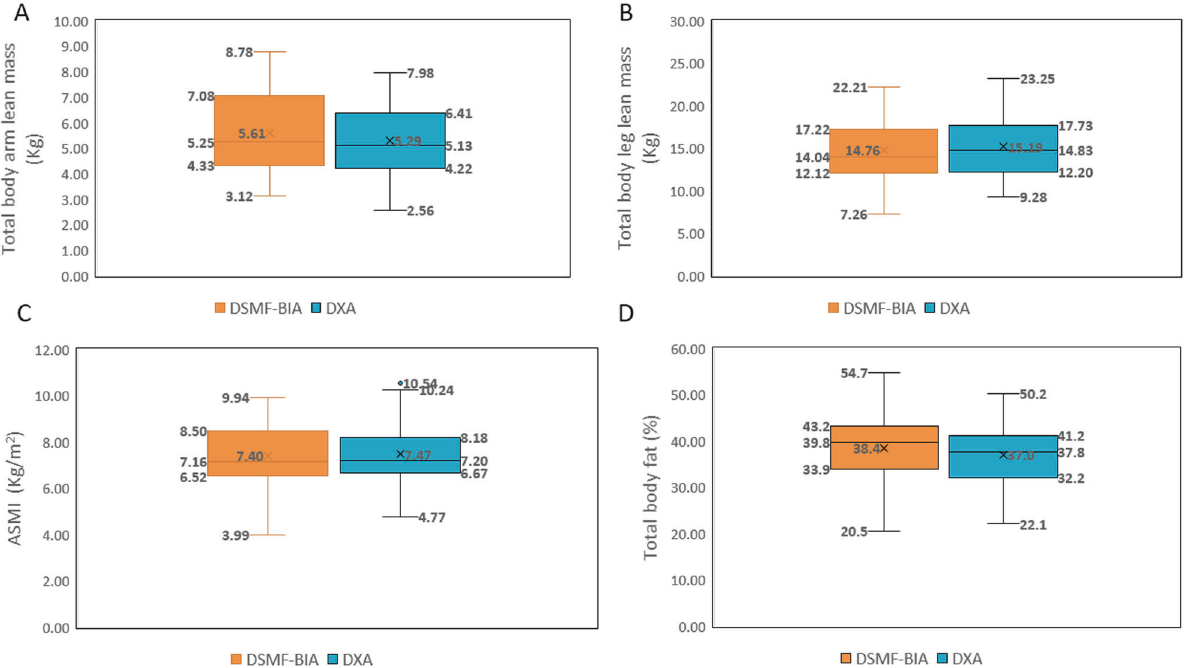
Fig. 1 Box plots distribution of DSMF-BIA and DXA lean, ASMI and % body fat values. Box plots showing the mean values (represented by X), median values (inner line within the box), interquartile range (IQR) (Q1 – Q3) values and lines indicating variability outside the upper and lower quartiles (minimum = Q1 – 1.5*IQR; maximum = Q3 + 1.5*IQR) values of: A arms lean body mass; B legs lean body mass; C ASMI; D % fat. DSMF-BIA distribution is represented by the left box in each sub- fi gure; DXA distribution is represented by the right box in each sub- fi gure. ASMI appendicular skeletal mass index, DSMF-BIA direct segmental multi-frequency bioelectrical impendence analysis, DXA dual- energy X-ray